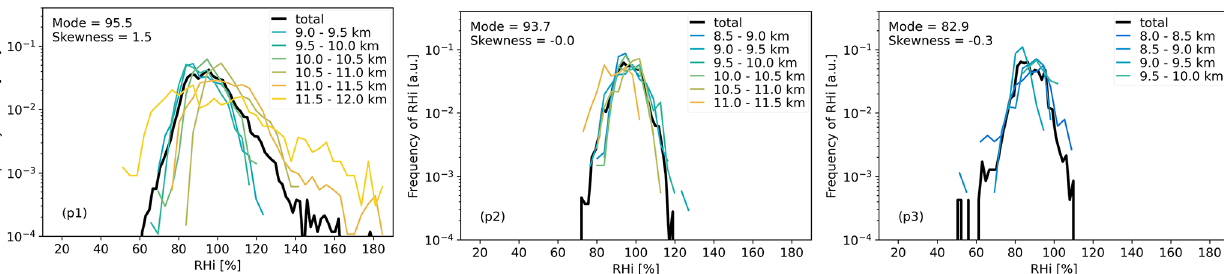
Figure 9. PDF of in-cloud RHi in vertical layers with 500m depths from the cloud bottom to the cloud top. From left to right: (p1) young phase, (p2) mature phase and (p3) stable phase, in accordance with Fig. 8. The number of layers differs depending on the geometrical depth of the cloud and the depth at which the lidar could provide